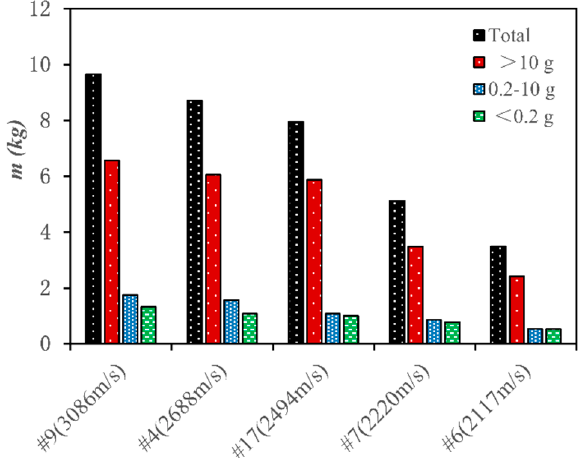
Figure 10. Mass distribution of the concrete fragments.